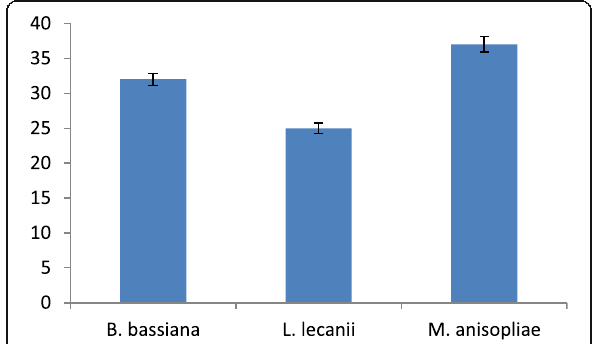
Fig. 2 Protease activity of the EPF isolates of Beauveria bassiana , Lecanicillium lecanii , and Metarhizium anisopliae (average diameter of clear zone, millimeter)